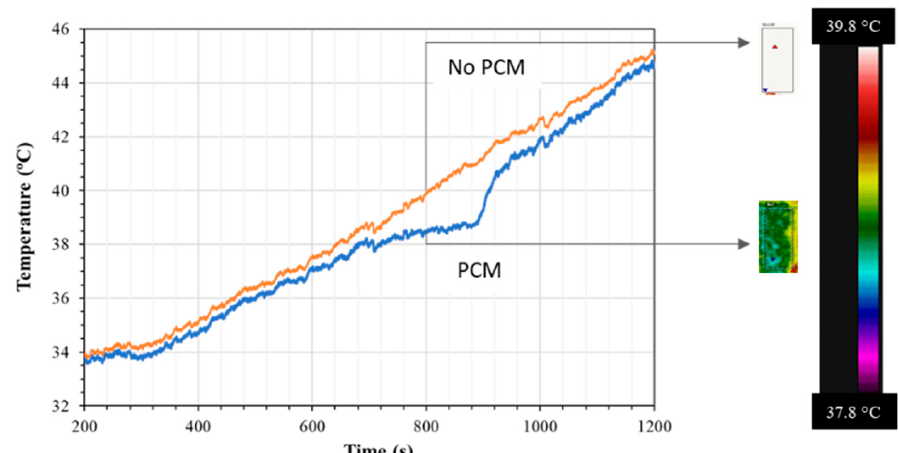
Figure 9. Surface temperature profiles detected by an IR thermal camera between samples containing an anodic structure that was annealed and sealed (orange line) and one that had the annealed anodic structure containing PCM and sealed (blue line). The thermal images along the scale bar of the FLIR are observed on the right side of the image.